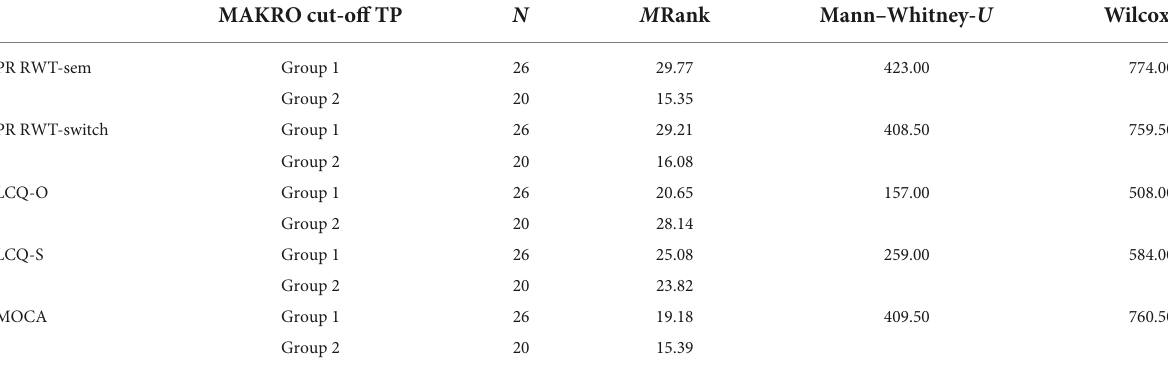
TABLE 7 Results of the Mann–Whitney- U -Tests for group comparisons, MAKRO subtest “Text Production” ( n = 46). MAKRO cut-off TP N M Rank Mann–Whitney- U Wilcox-W